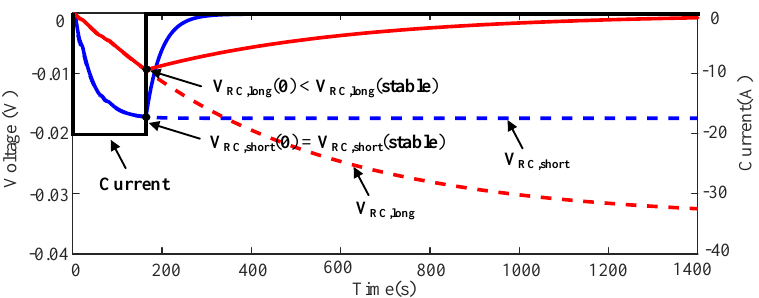
Figure 7. The voltage curve of RC networks during one cycle of the discharging pulse-rest test.